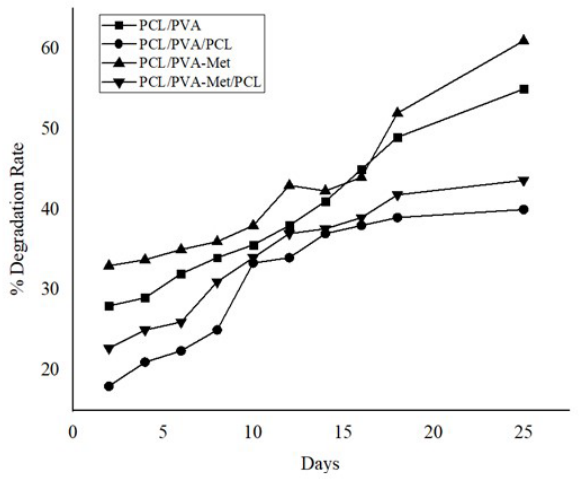
Figure 4. Degradation rates of 3D-printed scaffolds.